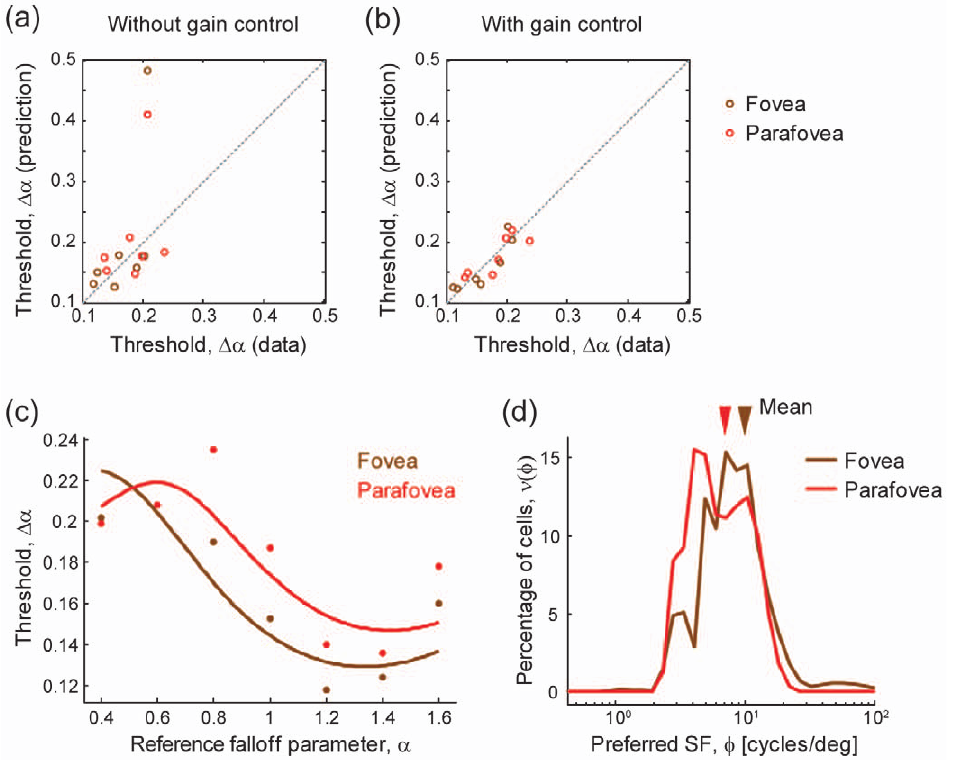
Figure 4. Estimating neuronal distributions so that they fit the model prediction with the data. Data are the same as in Fig. 2. (a,b) Model predictability (a) without and (b) with gain control within hypercolumn. In both models, we fitted the data by varying the numbers of neurons as the fitting parameters. (c) Data fitting by model that takes into account gain control within hypercolumn. (d) Estimated neuronal distributions using the model with gain control. The arrows above the histograms indicate the mean preferred spatial frequency of neurons within foveal (brown) or parafoveal (red) hypercolumns. We set the model parameters l b and p in Eq. (7) as l b ~ 20 and p ~ 0 : 9 .